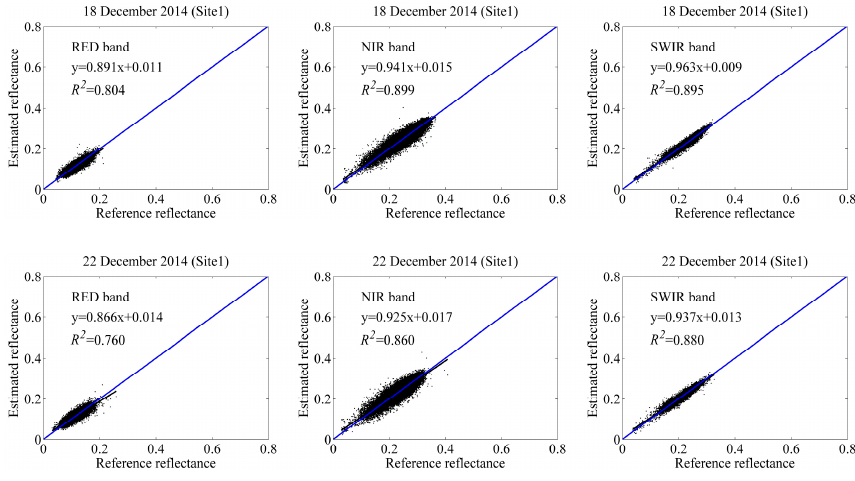
Figure 4. Cont. Figure 4.